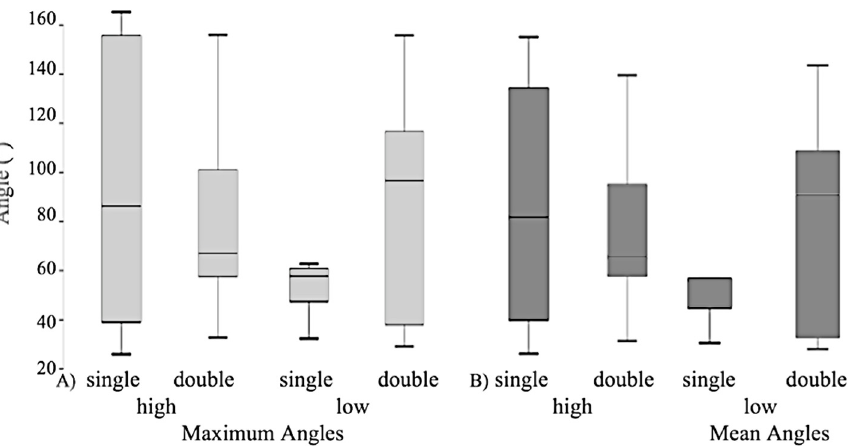
Figure 4. Mean and Mean max pull pressure >50 N recorded for 6 horses eating from either a single or double layered haynet and when hung low or high (s.e. bars shown; *** p < 0.001; ** p < 0.01; Wilcoxon).